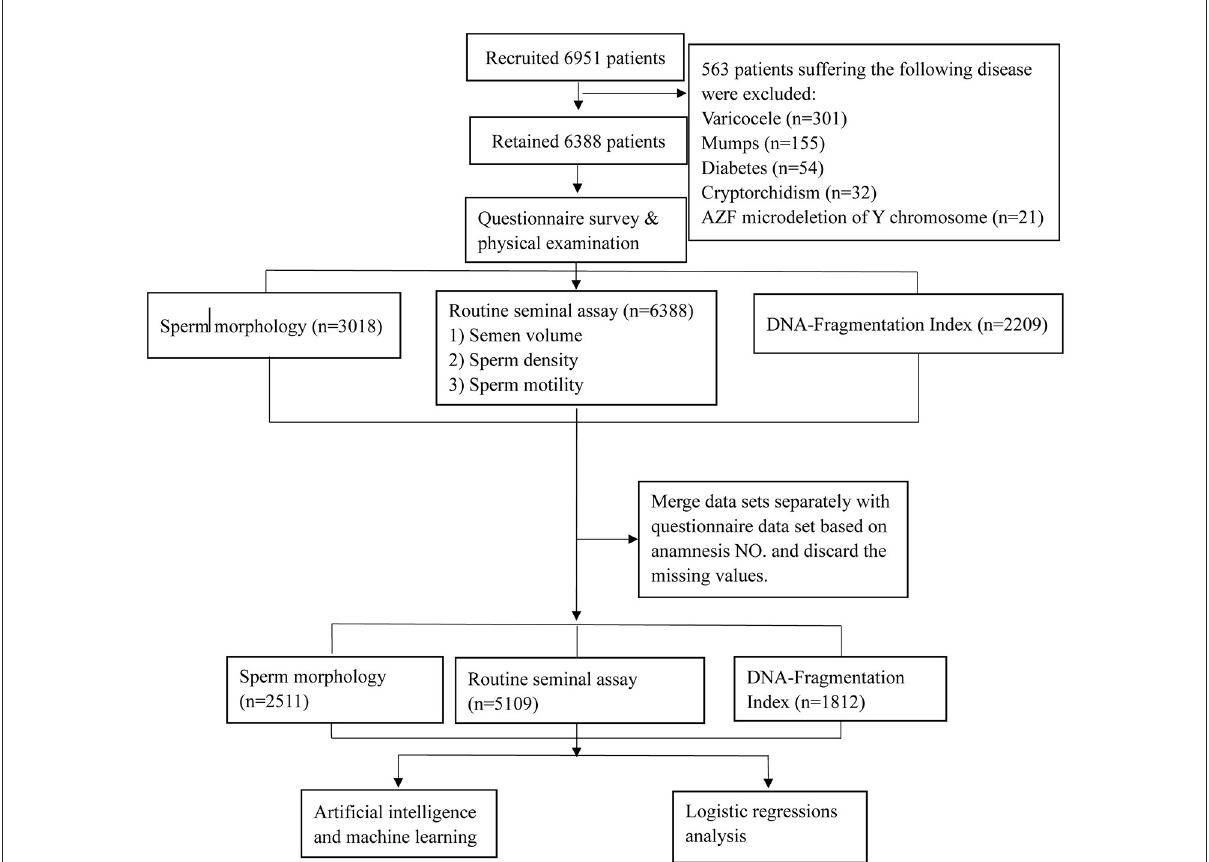
FIGURE1 Flow chart of the study population. A total of 5,109 males were included in this study; all of these participants underwent a routine seminal assay while some also underwent sperm morphology and DNA Fragmentation Index assay according to the different inspection purposes.